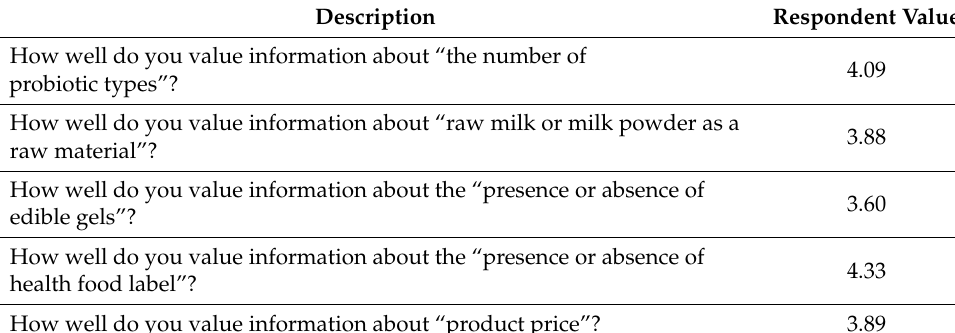
Table 6. Respondents’ values to yogurt product